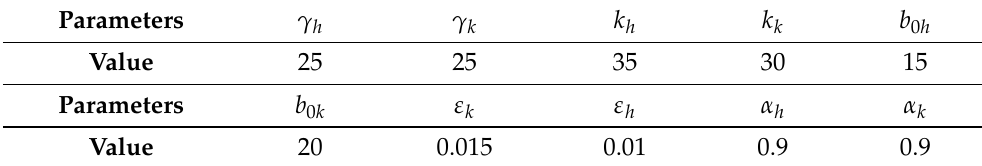
Table 2. NLESO-based controller’s